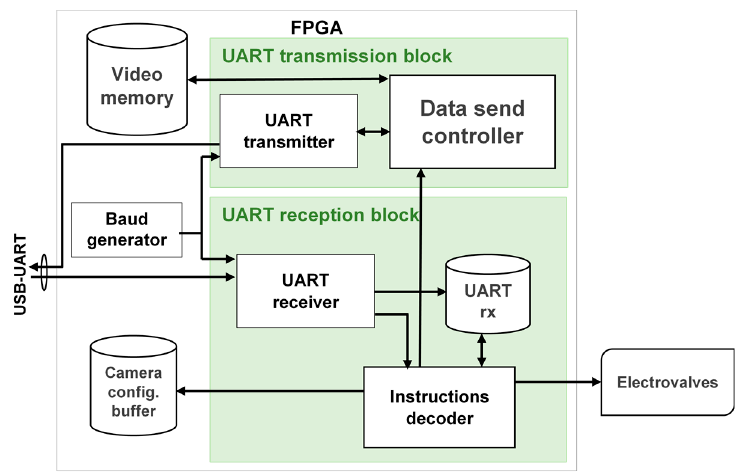
Figure 7. The Universal Asynchronous Receiver/Transmitter (UART) driver block diagram.